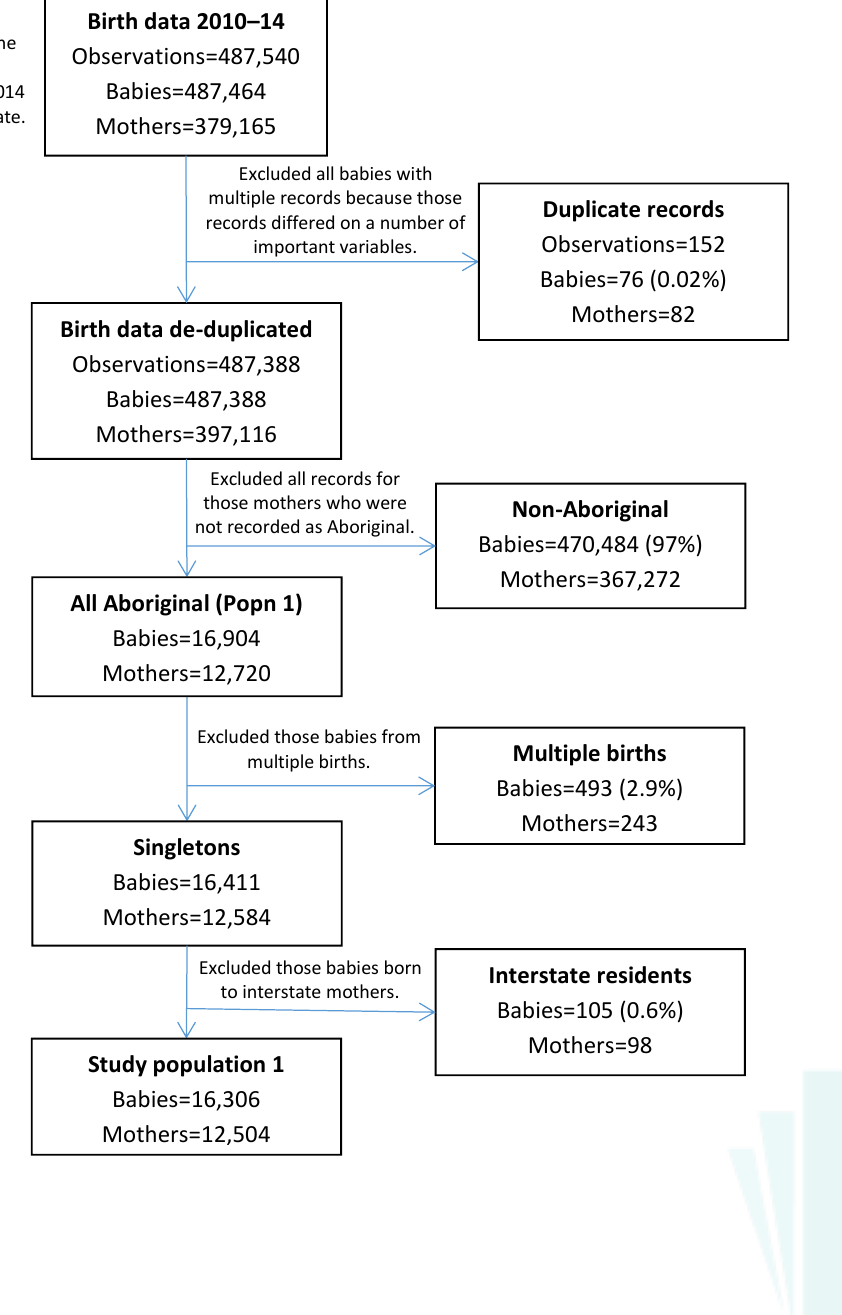
Figure 3: Flow diagram of mothers and babies eligible for inclusion in study population 1. Aboriginality of mothers in this study population was based only on what is recorded in the birth data; no enhanced reporting of Aboriginality was used.